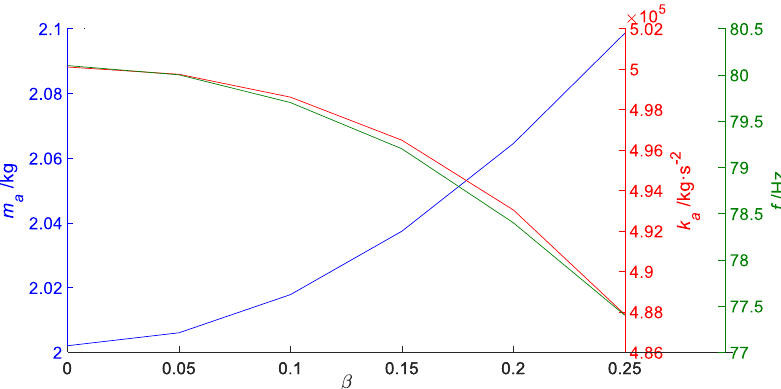
Figure 2. The modal mass m a , modal stiffness k a and resonance frequency f of the acoustic mode according to the specific impedance ratio β .